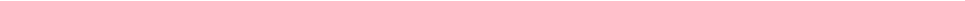
(see fi gure on previous page) Fig. 4 JMJD3 epigenetically induces expression of syntenin in Ras-activated lung cancer cells. a Expression level of p-smad2, p-smad3 in BZR cells transfected with the indicated plasmids in response to TGF- β 1 (5 ng/ml) for 1 h. b Transwell migration assay on BZR cells transfected with the indicated plasmids in response to TGF- β 1 (5 ng/ml). Columns, mean of two independent experiments performed in triplicate; bar , S.D.; *** P < 0.001 versus control. c Syntenin protein expression in BEAS-2B, A549, H358, H1299, and BZR cells. d Real-time RT-PCR analysis of syntenin mRNA levels in BEAS-2B and BZR cells. Data are presented as the mean±s.d. of three independent experiments; bar , S.D.; *** P < 0.001 versus BEAS-2B. e Real-time RT- PCR analysis (upper panel) and western blot analysis (lower panel) of syntenin expression in A549 cells in response to GSK-J4. Columns, mean of three independent experiments performed in triplicate; bar , S.D.; *** P < 0.001 versus control. f Real-time RT-PCR analysis (upper panel) and western blot analysis (lower panel) of JMJD3 and syntenin expression levels in BZR cells in response to knockdown of JMJD3. Columns, mean of three independent experiments performed in triplicate; bar , S.D.; *** P < 0.001 versus control. g Real-time RT-PCR analysis (upper panel) and western blot analysis (lower panel) of JMJD3 and syntenin expression levels in BEAS-2B cells transfected with control or HA-tagged JMJD3. Columns, mean of three independent experiments performed in triplicate; bar , S.D.; *** P < 0.01 versus control. h A representative image of immunohistochemical staining with JMJD3 and syntenin in human lung cancer tissue microarray. Scale bar, 50 μ m. i The positive correlation between JMJD3 and syntenin expression in human lung cancer tissues. Pearson ’ s coef fi cient tests were performed to assess signi fi